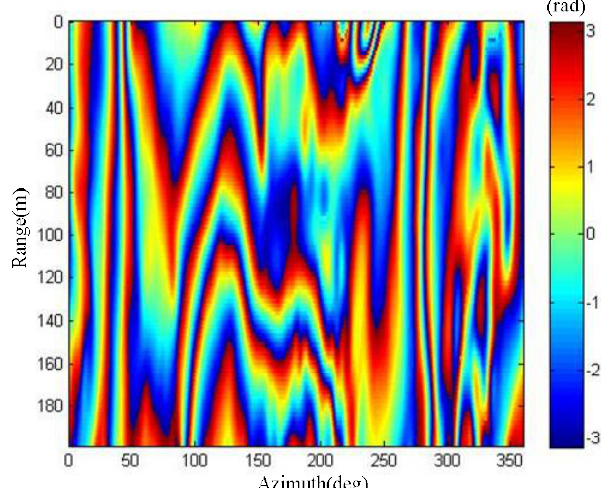
Figure 19. Interferometric phase image of phase wrapping.